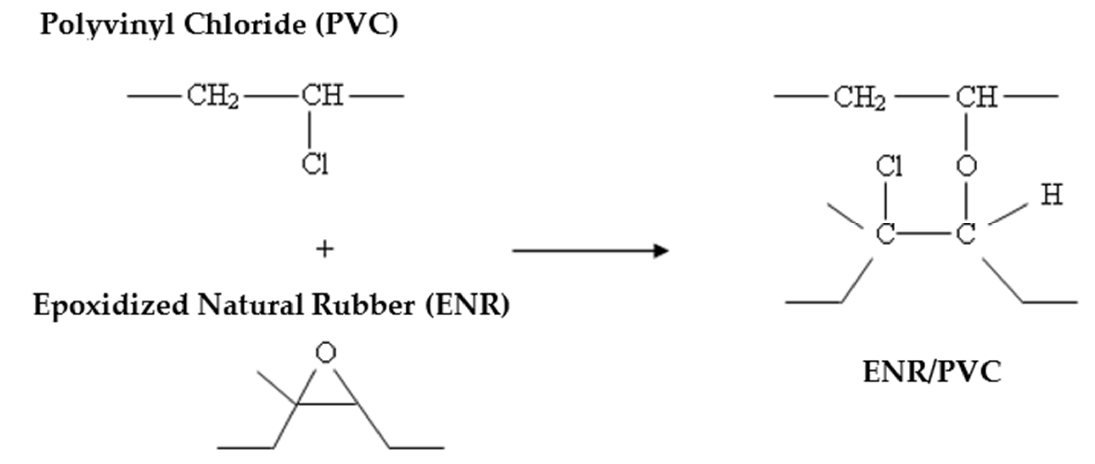
Figure 7. Crosslinking reactions between ENR and PVC. Redrawn from [183], Wiley, 1991.